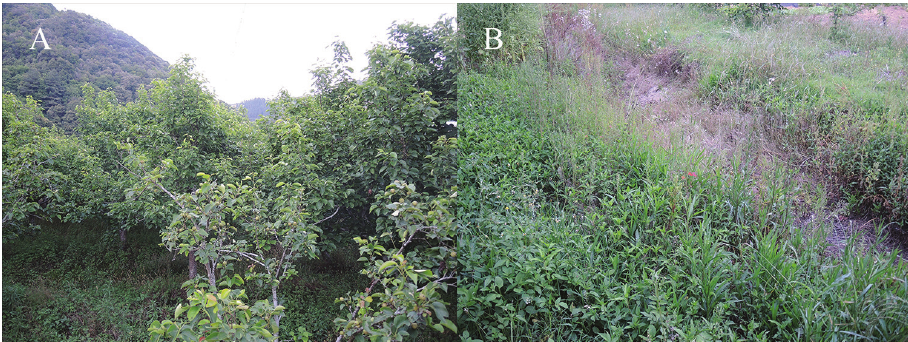
Figure 8. The fruit garden A and dry puddle B in the fruit garden at type locality of Kurixalus lenquanensis sp.